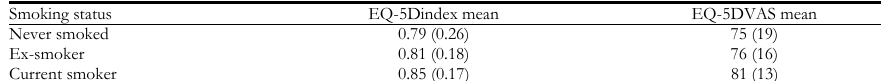
EQ-5D index mean and VAS mean for Smoking status